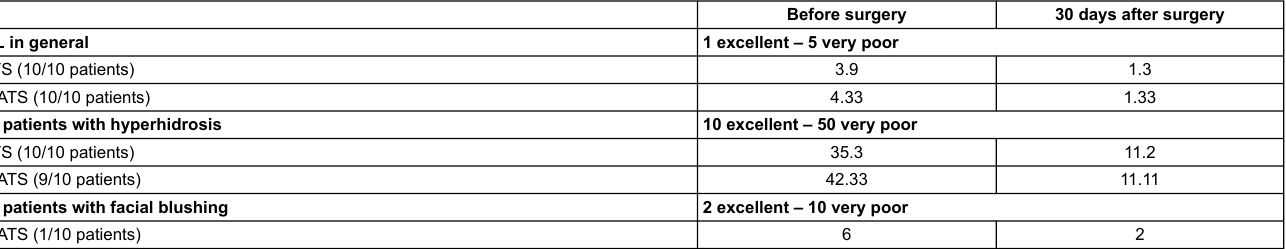
Table 5: Quality of life results.